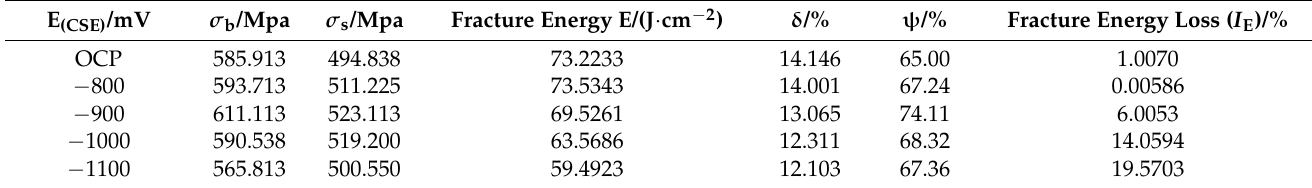
Table 2. The tensile properties of X80 steel under different CP potentials in soil medium at 30 ◦ C.